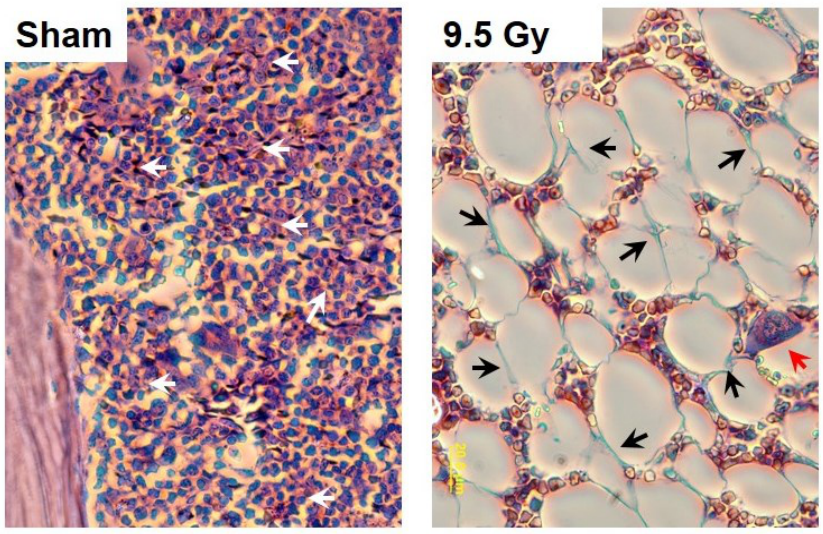
Figure 3. Radiation-induced depletion of bone marrow tissue with hematopoietic cells occurs in mice experienced hARS. Hematopoietic cells are indicated with white arrows in a “sham” specimen (left panel). Depletion with hematopoietic cells is observed after IR (ionizing irradiation ) with 9.5 Gy (gray). The myeloablation reveals the presence of the open reticular meshwork of the stromal cells. The stromal cells (in blue) are indicated with black arrows in the right panel. A large macrophage containing phagocytized hematopoietic cells is shown with a red arrow in the right panel. Collected at 22nd day following IR. Hematoxylin and eosin staining. Experimental conditions are indicated in Figure